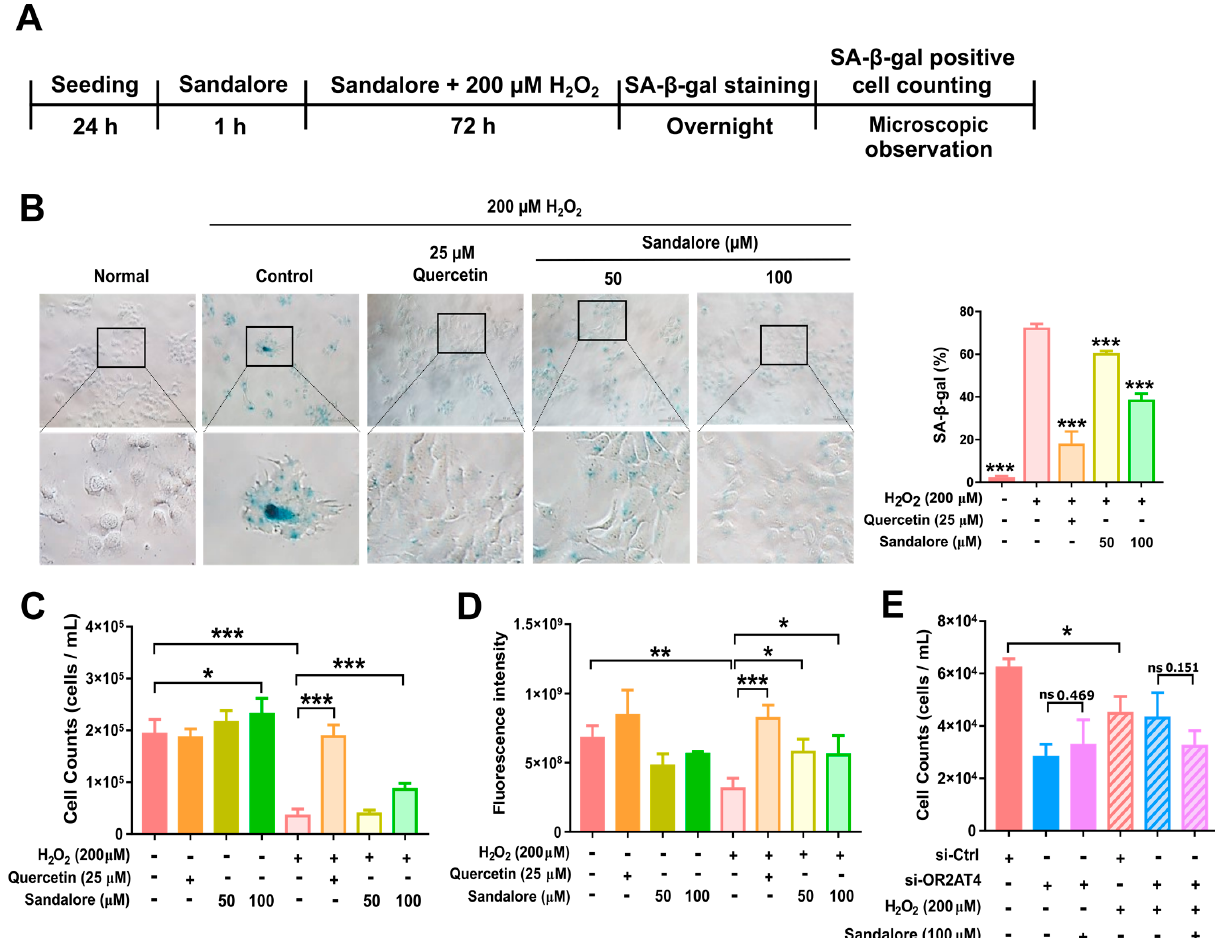
Figure 3. OR2AT4 activation by sandalore restored the senescence phenotype and cell proliferation in HaCaT cells. ( A ) Schematic representation of the experimental design. ( B ) Representative im- ages of SA- β -gal staining. Original magnification, 200×. Scale bar, 50 µm (left panel). Quantifi- cation of SA- β -gal-positive cells (right panel) was analyzed using ImageJ software. ( C ) Live cell counting ( n = 6), ( D ) cell proliferation assay ( n = 3), and ( E ) live cell counting in OR2AT4 -knock- down HaCaT cells. Quercetin was used as a positive control. Data are means ± SEM. * p < 0.05, ** p < 0.01, and *** p < 0.001. Student’s t -test was performed for the comparisons between groups. Next, we assessed the expression of p21 and Ki-67. p21 is a pleiotropic inhibitor of the cyclin/cyclin-dependent kinase complexes that mediate cell cycle progression. The in- duction of p21 causes cell cycle arrest in senescent cells [28]. Ki-67 is a nuclear protein that is highly expressed in asynchronously cycling cells and is absent in non-dividing cells [29]. It is a common marker of proliferating cells [30]. The H 2 O 2 -induced senescent cells expressed a higher expression of p21 mRNA compared with non-senescent cells (Figure 4A). Quercetin, a positive control, reduced the p21 mRNA expression in non-senescent and senescent cells. Sandalore did not affect the p21 expression in non-senescent cells, but significantly suppressed the p21 expression in senescent cells (Figure 4A). The immunob- lotting analysis showed similar trends for p21 protein and mRNA expression (Figure 4B). The Ki-67 mRNA expression was lower in senescent cells than non-senescent cells (Figure 4C). Sandalore significantly increased the Ki-67 gene expression in senescent cells. Additionally, quercetin increased the Ki-67 mRNA expression in non-senescent and se- nescent cells. Sandalore selectively increased the Ki-67 expression in senescent cells, but not non-senescent cells (Figure 4C). These findings suggest that sandalore may recover